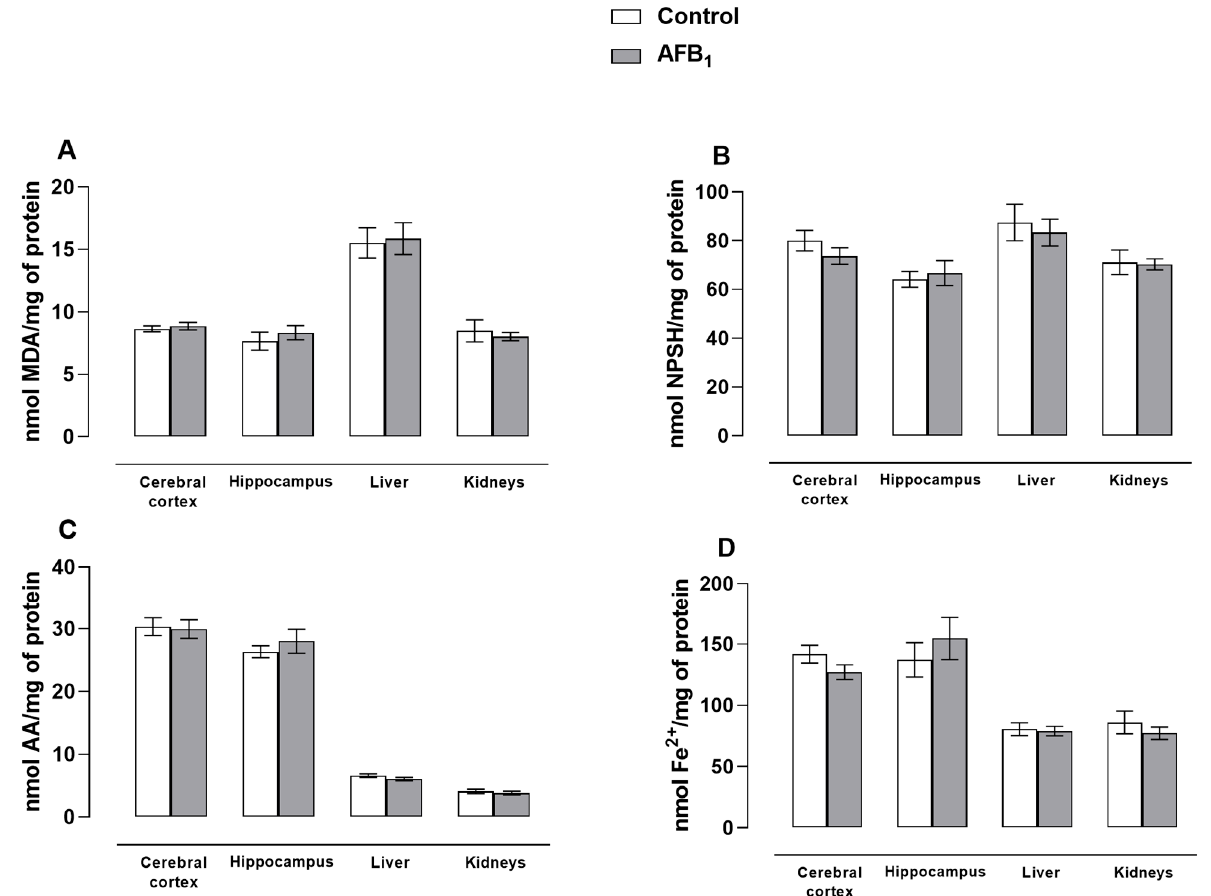
Figure 2. Effect of intermittent administration of AFB 1 (250 μ g/kg b.w., i.g.) or 2% DMSO (10 mL/kg b.w., i.g.) on TBARS levels ( A ), NPSH levels ( B ), ascorbic acid levels ( C ), and FRAP determination